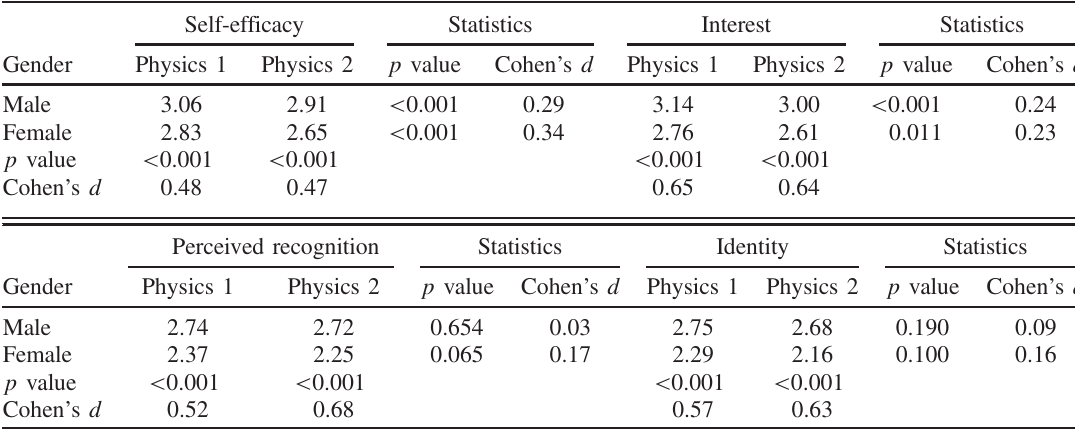
TABLE III. Descriptive statistics of female and male students ’ motivational beliefs (matched students in physics 1 and physics 2). The sample size is 695 (462 male students and 233 female students). Cohen suggested that a